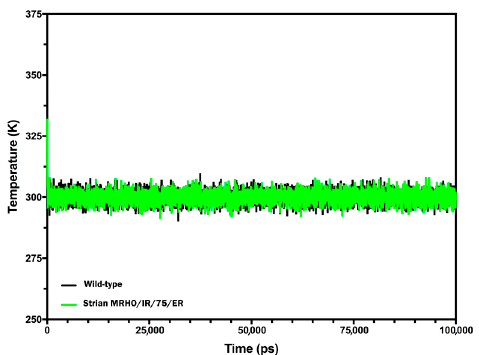
Figure 5. Temperature fluctuation of CYP51 protein from wild-type (black) and strain MRHO/IR/75/ER (green) during the 100 ns production step of the MD simulation.